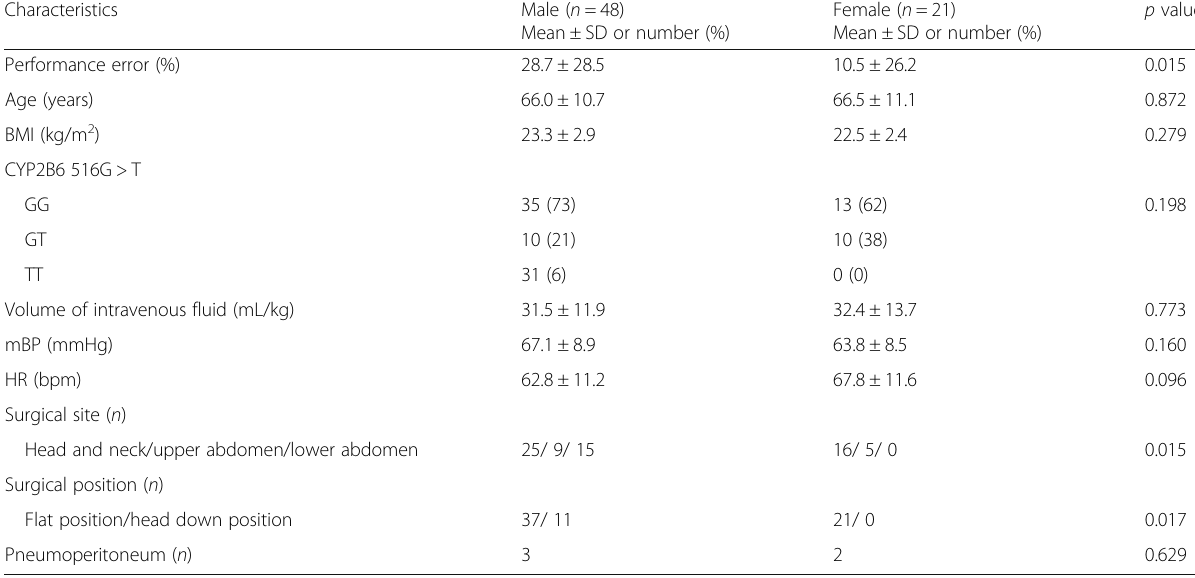
Table 1 Baseline characteristics and clinical factors of the study subjects stratified by sex